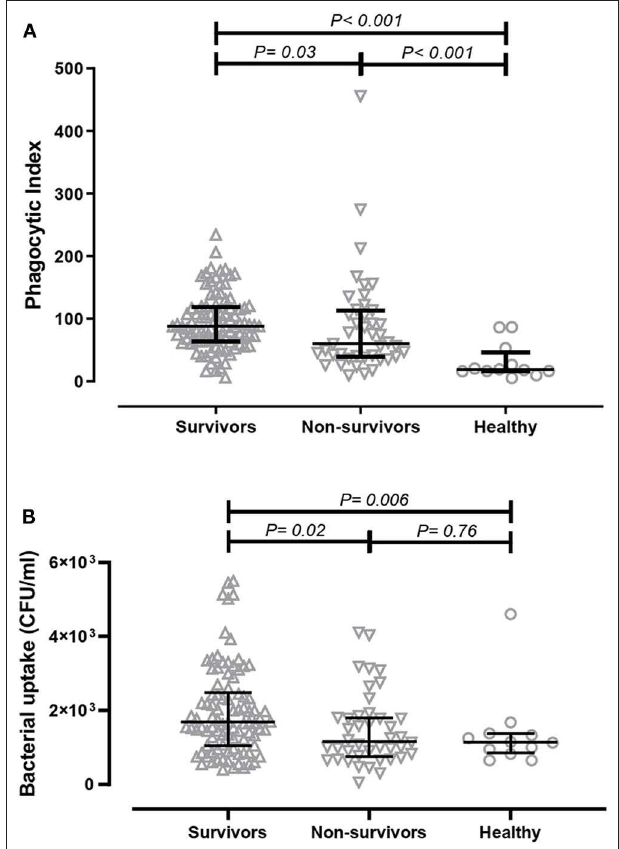
FIGURE 1 | Comparison of in-vitro antibody-dependent cellular phagocytosis (ADCP) activity of serum derived from acute melioidosis patients who survived the disease (upward open triangles), acute melioidosis fatal cases (downward open triangles) and healthy endemic controls (open circle). (A) The ADCP activity in human monocyte THP-1 cells were determined by flow cytometry and expressed as phagocytic index (described in Material and Methods). (B) The ADCP activity of antibodies was also determined in THP-1-derived macrophages using the colony count method to detect live bacteria inside infected cells. The statistical test used for comparison is the Kruskal-Wallis one-way ANOVA for more than two groups, and Mann-Whitney U for two